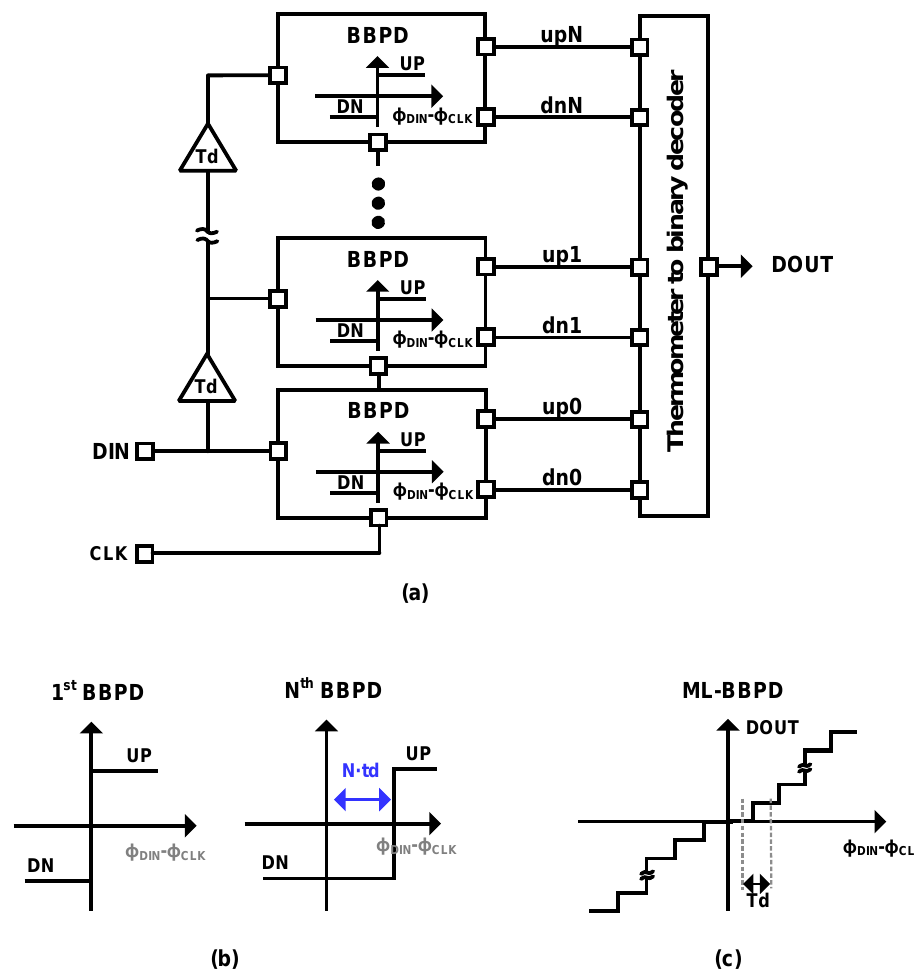
Figure 8. ( a ) Multi-level BBPD schematic and ( b ) its transfer function, ( c ) the phase difference between the input data and the clock